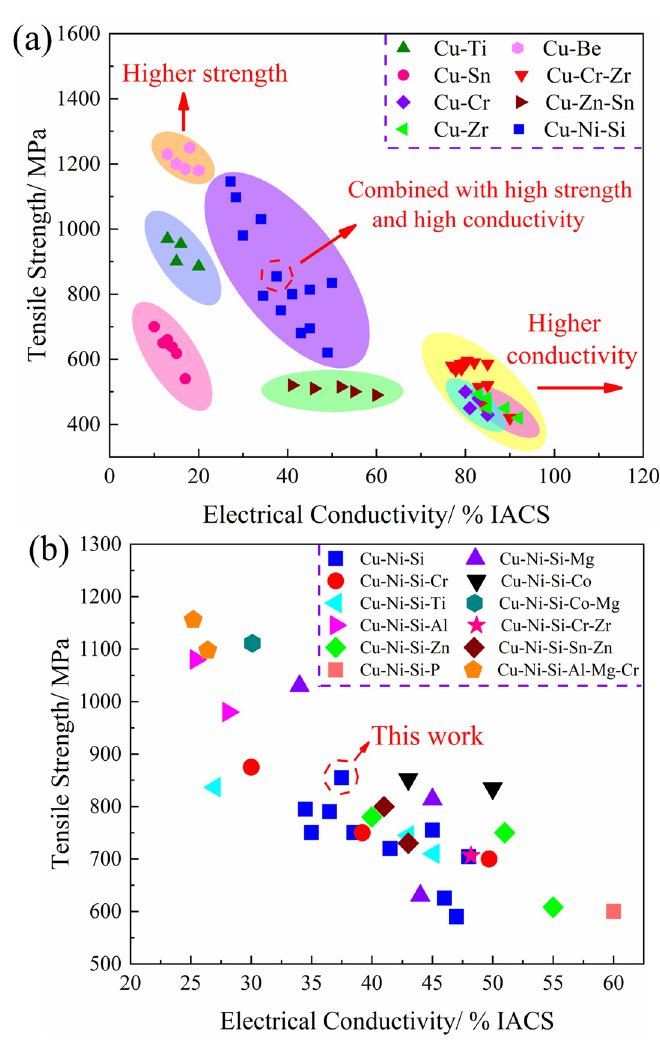
Figure 16. Comparison of tensile strength and electrical conductivity of high ‐ strength copper alloys.